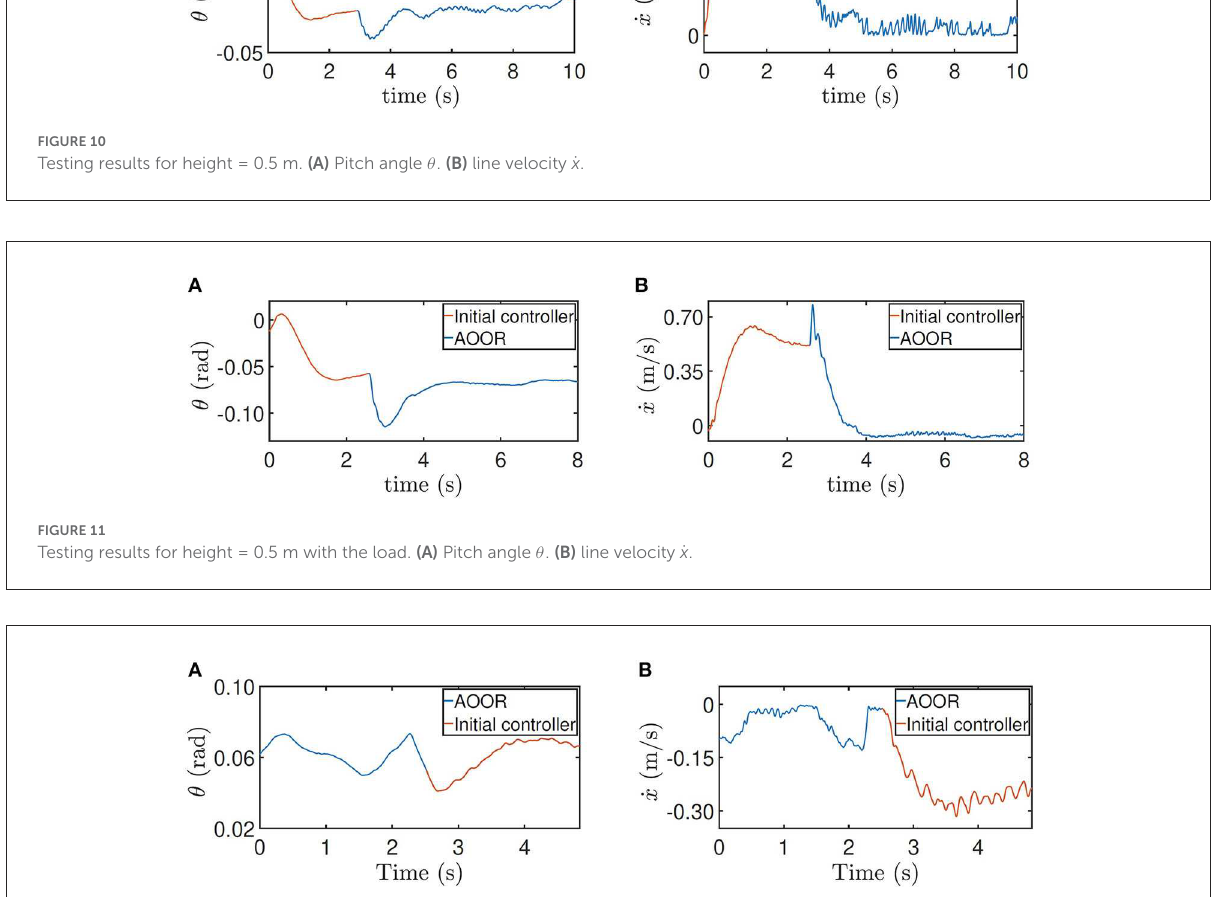
FIGURE12 Testing results for height = 0.5 m on the slope. (A) Pitch angle θ . (B) line velocity ˙ x